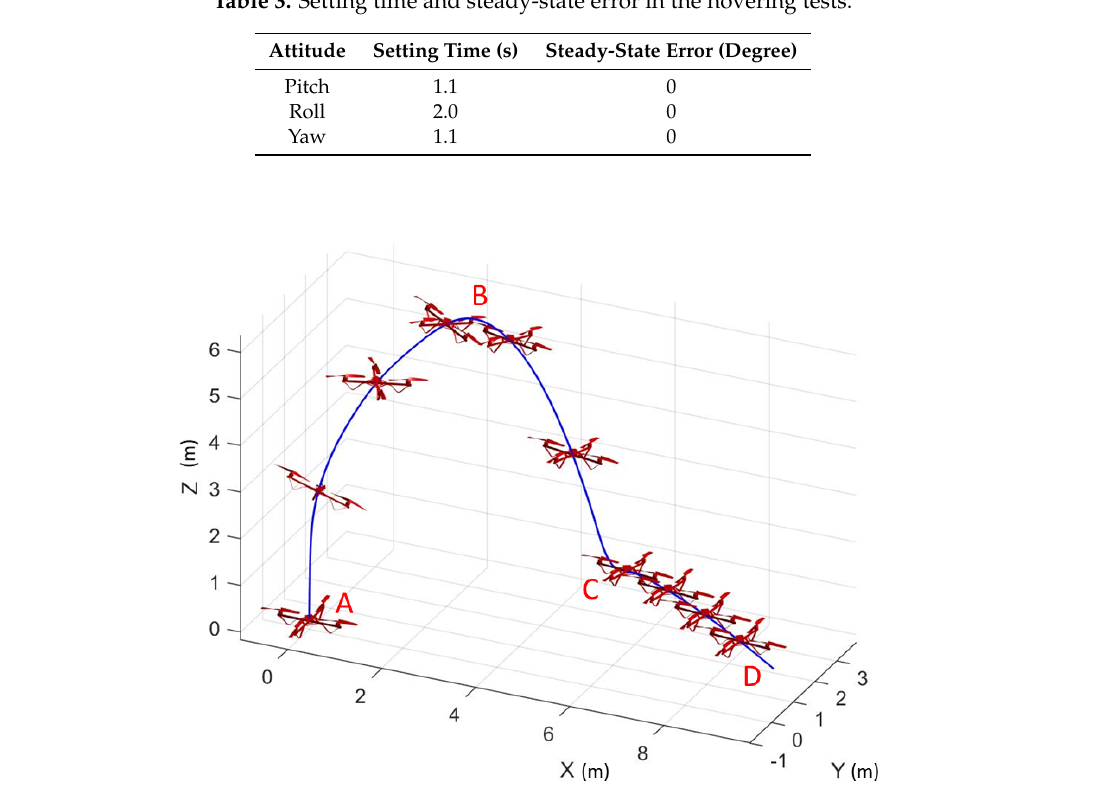
Table 3. Setting time and steady-state error in the hovering tests.